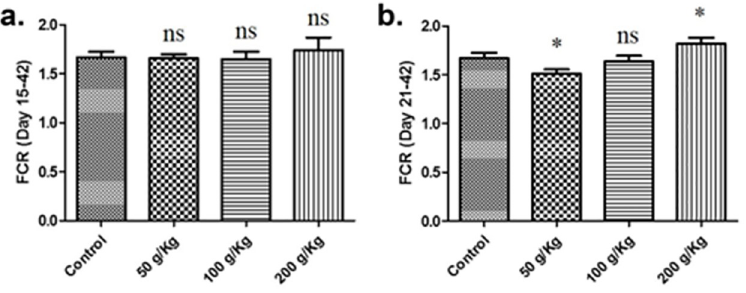
Fig 1. Graphs showing the comparison of feed conversion ratio (FCR) of different quinoa enriched diet given chicken groups. The chickens were given 50 g/Kg, 100 g/Kg and 200 g/Kg of quinoa. ( a ). FCR ratio of chicken fed from days 15 to 42post-birth ( b ). FCR ratio of chicken fed from days 21 to 42 post-birth. All data are expressed as means ± standard deviation (SD) from measurements on 15 chickens. � p � 0.05 in all quinoa supplemented diet fed groups versus the commercially available diet without quinoa fed control group. Note : ns means not